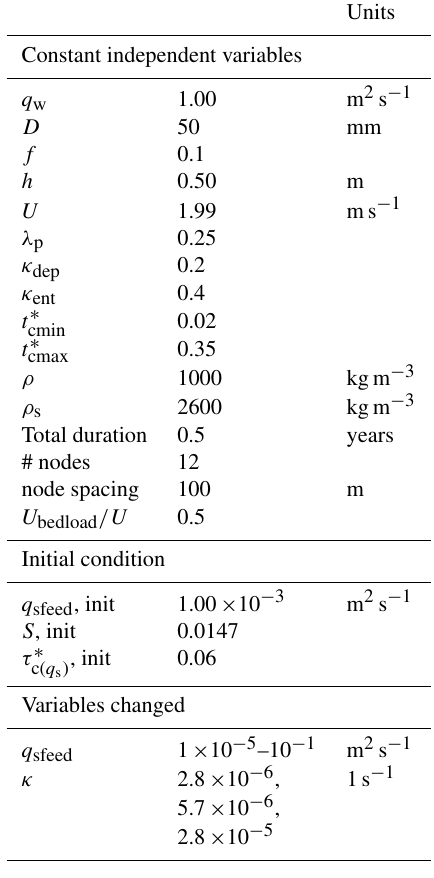
Table 2. Morphodynamic model parameters.